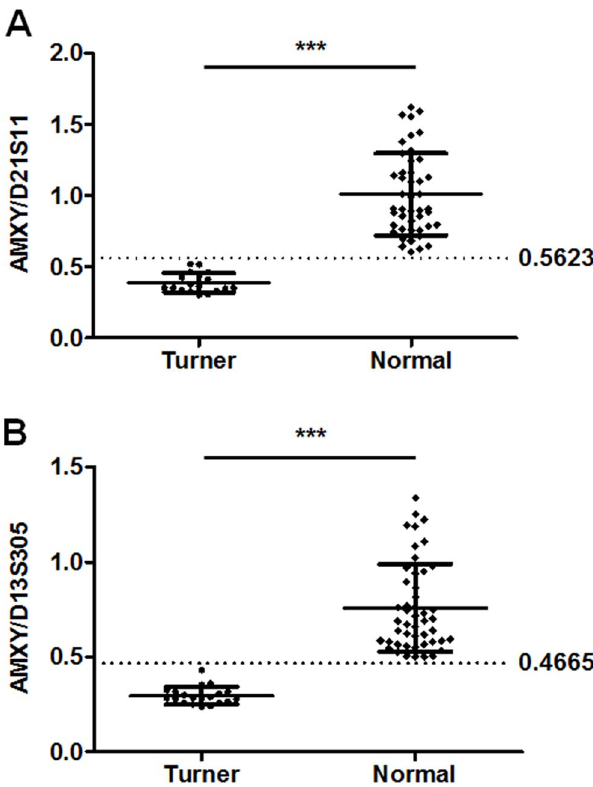
Figure 3. Comparison of peak ratios of AMXY to autosomal internal controls ((A) D21S11 and (B) D13S305) between confirmed Tuner samples and normal samples. Unpaired t tests were used. *** P , 0.0001. Dash lines showed the cutoff values of AMXY/D21S11 (0.55) and AMXY/D13S305 (0.5), which would be used as the criteria for determination of Turner syndromes when suspected cases show single peaks for all X-linked markers and no peaks for AMY and